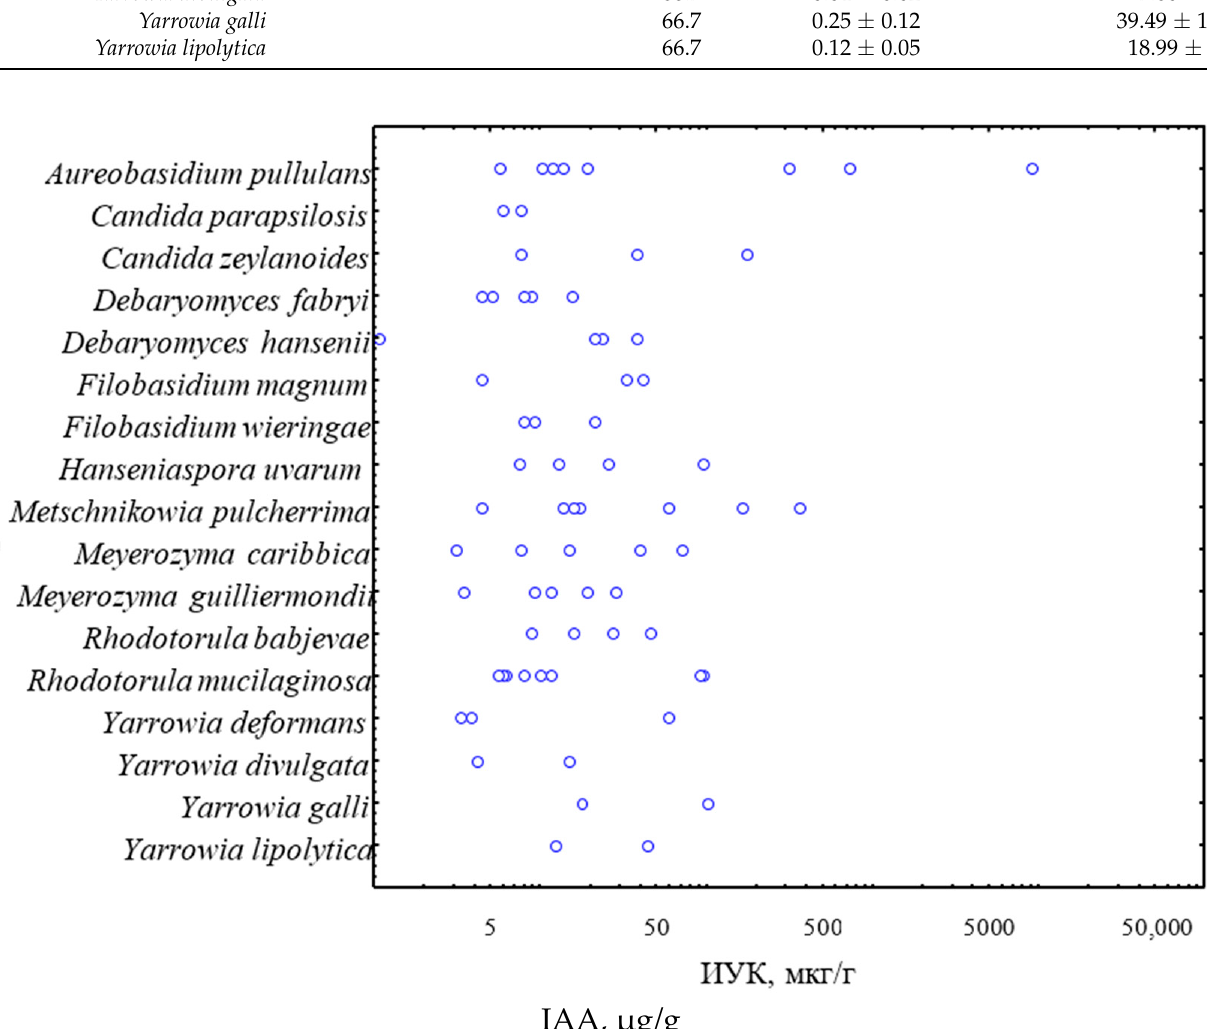
Figure 2. IAA production by the strains of the studied yeast species (logarithmic scale). Table 2. Proportion of active strains of the studied endophytic yeast species and average IAA pro- duction (with standard deviations) in the culture liquid and per unit biomass.